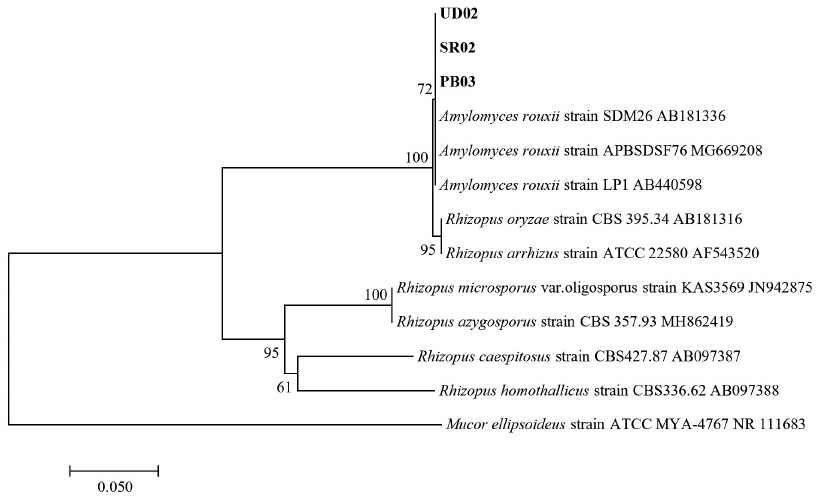
Fig. 5.(D). A phylogenetic tree of 3 isolates of Amylomyces rouxii (UD02, PB03, and SR02) constructed with the dataset based on ITS gene sequences. The tree was generated from Neighbor Joining Analysis (NJ), and NJ Boostrap (NJBS) values were calculated and shown on the